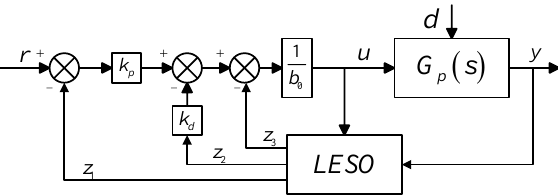
Figure 4. The Traditional Second-order LADRC